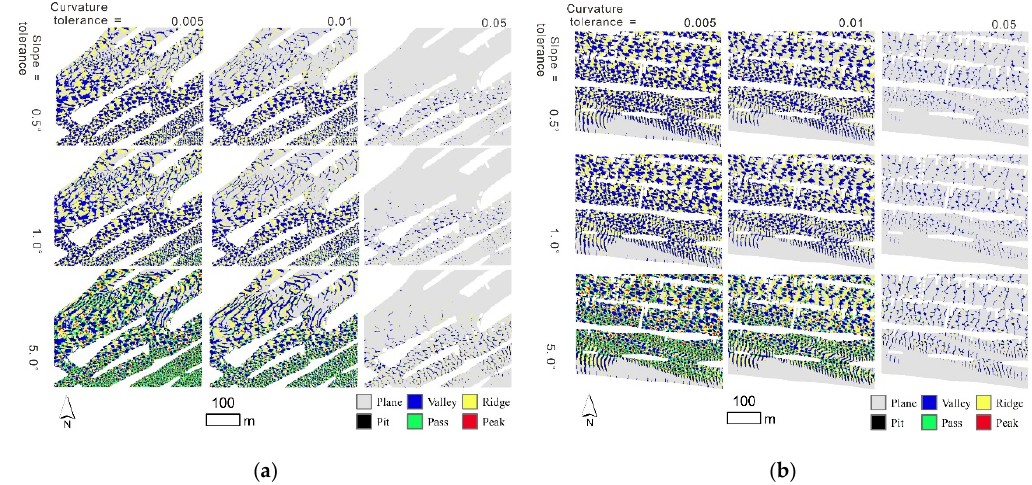
Figure 2. Wood’s criteria-based distribution of geomorphic elements with different slope tolerance in rows and curvature tolerances in columns for the sample data of ( a ) Chizhou Reach of the Yangtze River and ( b ) the Yangtze Estuary.